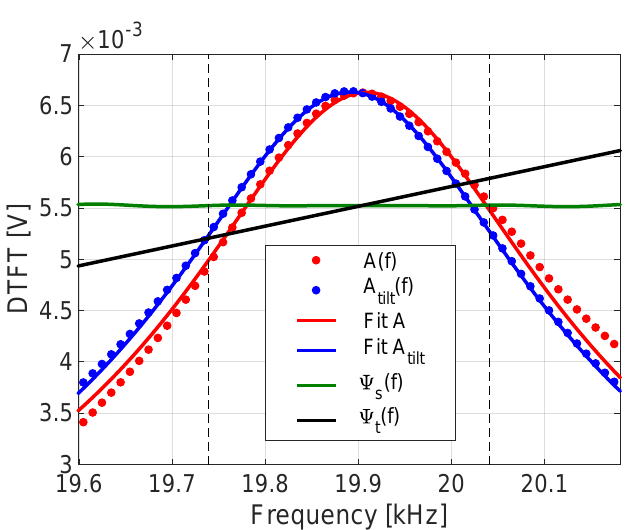
Figure 3. Discrete time Fourier transform of the output signal is shown as red symbols. The resulting fit using Equation (2) is shown as a red line. The tilting corrections introduced to compensate for the transducer and source frequency responses are shown as solid black and green lines, respectively. The corrected experimental data (blue symbols) and corresponding fitting curve (blue line) are perfectly superimposed. For the sake of readability, the number of data-points was reduced by a factor of 5. Vertical dashed lines show the fitting interval for